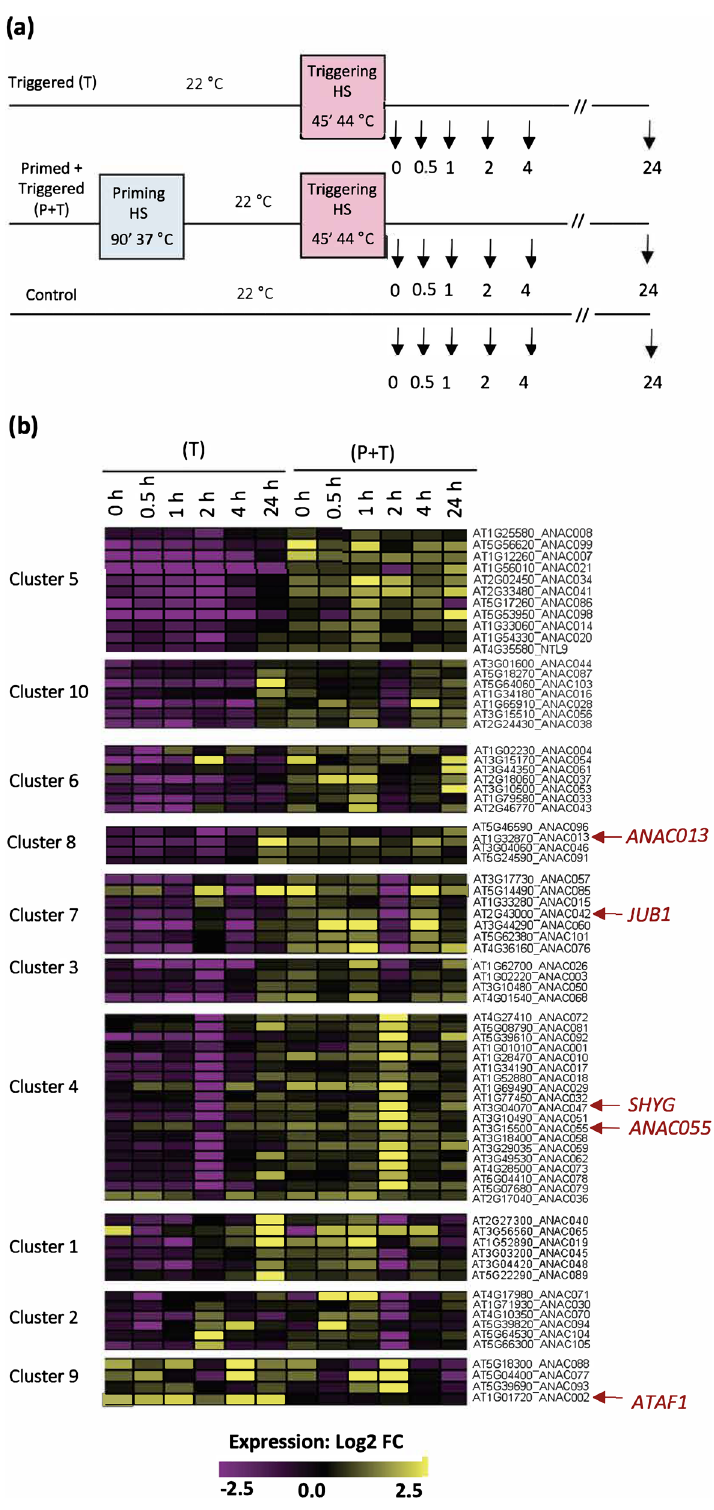
Figure 2. Expression of NACs after a triggering stimulus. ( a ) Schematic representation of the time points used for expression analysis of NACs in triggered plants (T), and in plants that were primed before triggering (P + T). In triggered (T) plants, the expression was calculated as a ratio of HS samples compared to unstressed controls. In primed and triggered (P + T) plants, the expression was calculated as primed and triggered (P + T), compared to triggered only (T). ( b ) K-means clustering of NAC expression profiles of primed and triggered (P + T) and triggered (T) plants after the triggering stimulus (k = 10 clusters). The expression of genes in each cluster is displayed as a heat map. The color indicates the expression as log2-fold change for the different time points, where yellow denotes an increased expression and purple a reduced expression. The list of genes in each cluster and their expression values are shown in Supplementary Table